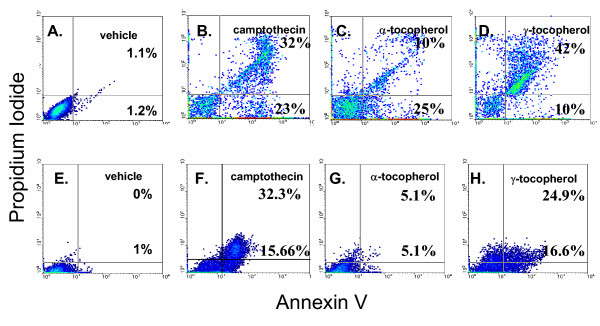
The annexin V/propidium iodide double staining assay following 100 μM tocopherol treatment in HCT-116 cells (Panels A-D) for 24 hours and SW480 (Panels E-H) cells for 70 hours. These data show RRR-γ-tocopherol is superior to RRR-α-tocopherol at inducing apoptosis. The percentages in right quadrants represent percentage apoptosis over the blank and are an average of at least two independent trials.